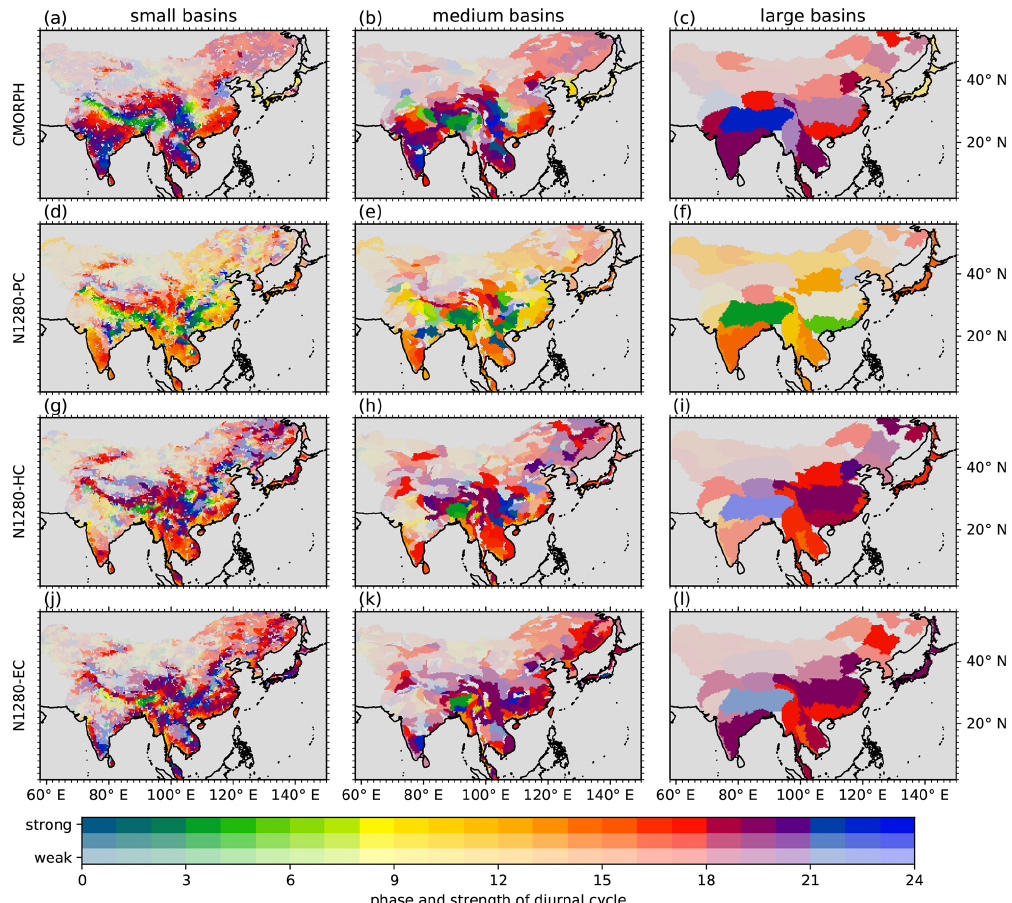
Figure 7. Diurnal cycle of amount of precipitation over Asia averaged over different basin scales (columns) for CMORPH, N1280-PC, N1280-HC and N1280-EC (rows). As described in Sect. 2.3 and as in Fig. 10, a visual representation of the amplitude is given by its strength, dependent on whether it is strong, medium or weak. This is calculated separately for each dataset and scale (i.e. for each panel).